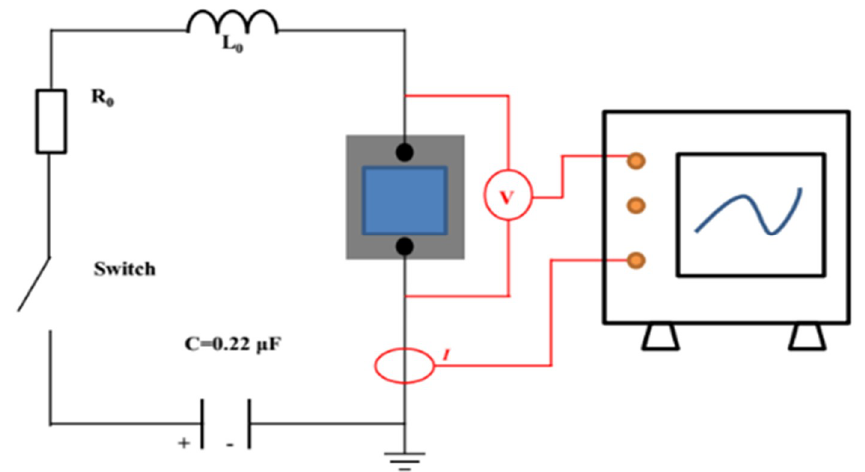
Figure 2. Schematic diagram of the electric explosion experiment device.